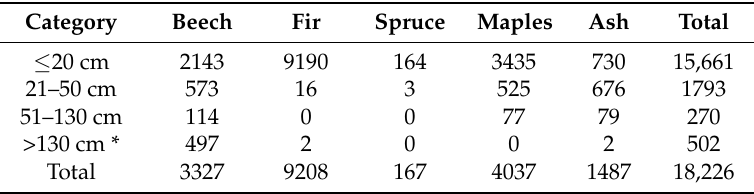
Table 3. Stand characteristics of the permanent research plot (PRP) by development stages (mean ± SD). Stand Characteristics Initial Stage Optimal Stage Decay Stage PRP Spatial proportion (%) 100 Tree density ≥ 8